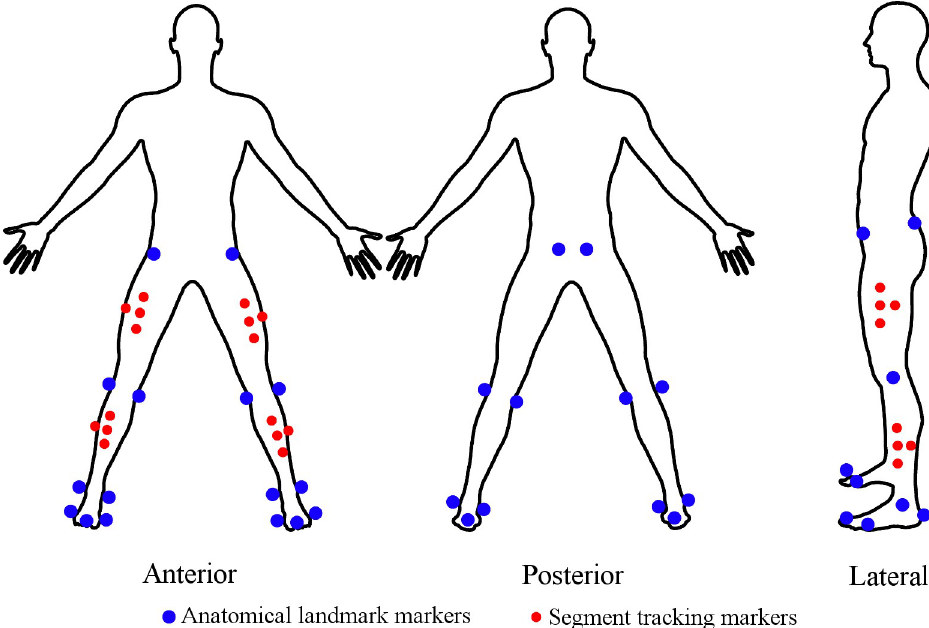
Fig 1. Lower body Plug-In-Gait model. Blue markers define the required anatomical landmarks, red markers are used for tracking segments.